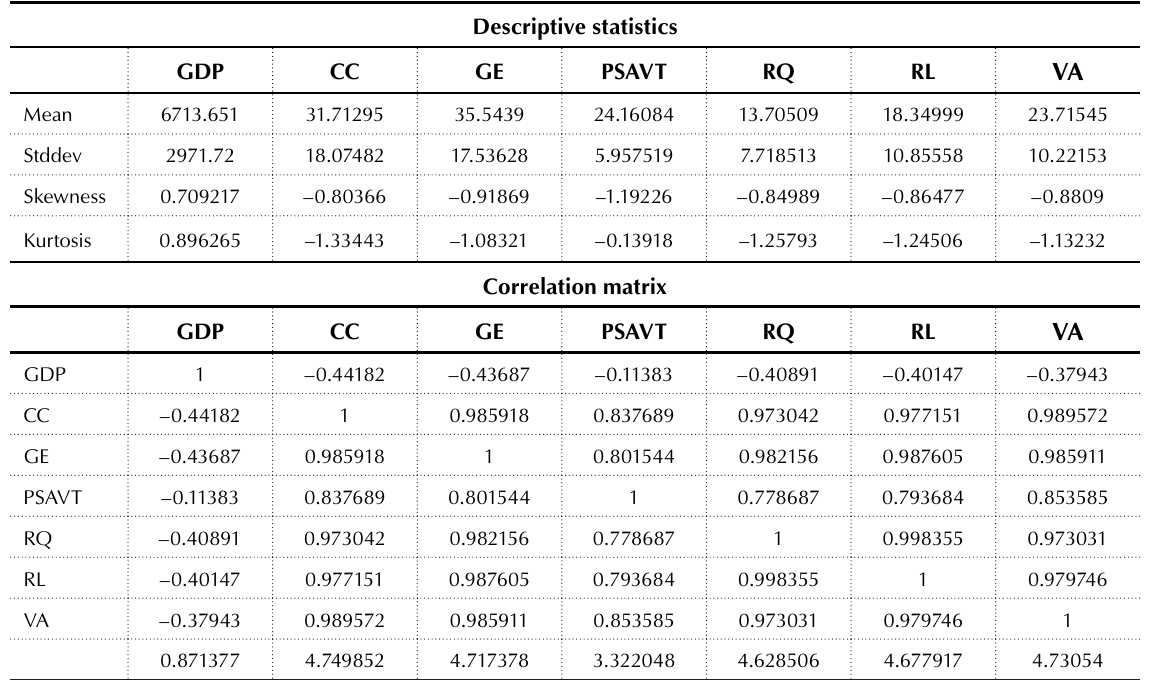
Table 6. Regression analysis, factor analysis – principal component extraction